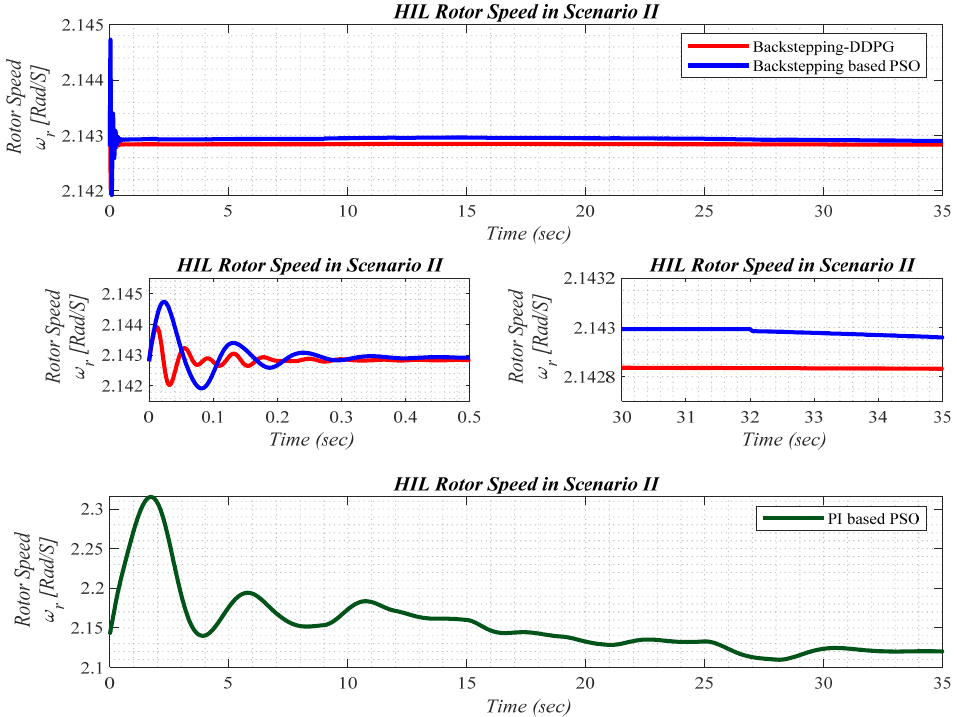
Figure 12. HIL output comparative results of backstepping controller based DDPG, backstepping controller based PSO and PI controller based PSO according to Scenario II.